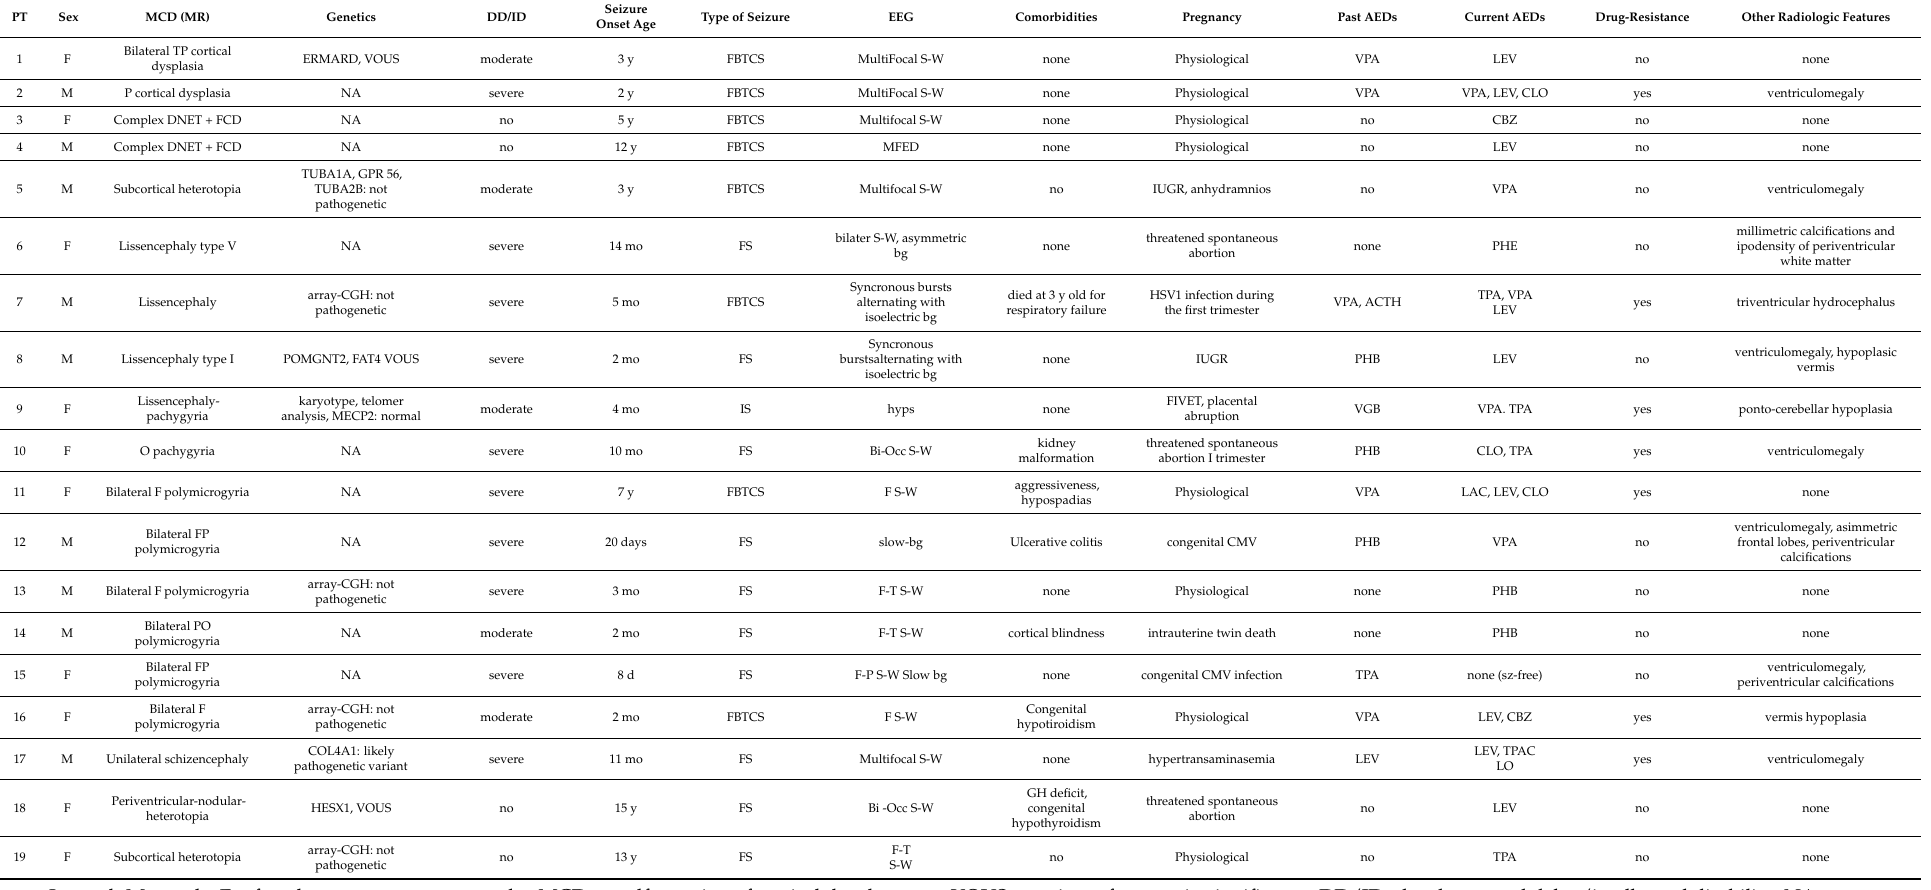
Table 1. Clinical features of patients with